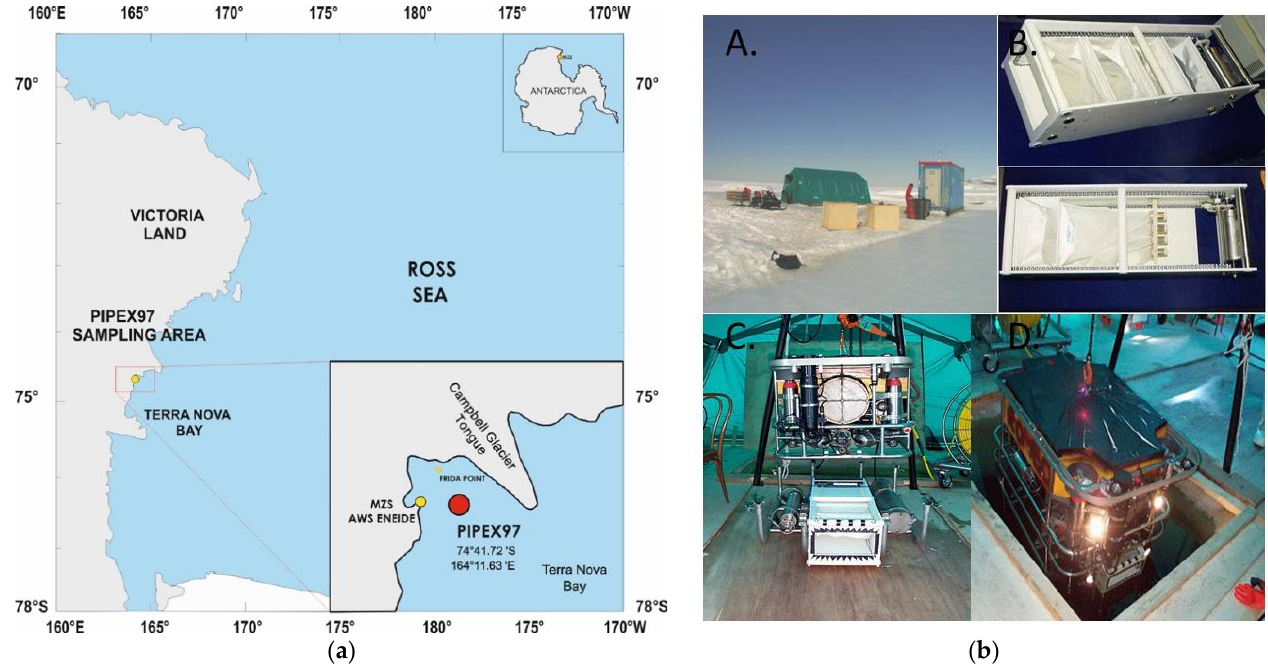
Figure 1. The field settings at the PIPEX 97 project sampling area, Terra Nova Bay, Antarctica, 1997. ( a ) The positions of the meteorological (ENEIDE) and the oceanographic (FRIDA) stations. ( b ) The biological station and the details inside the tent during field activities: (A) the sampling area on the pack-ice; (B) top view of the MicroNESS and position of the 4 sampling nets; (C) the attachment of MicroNESS to the ROMEO structure; (D) the deployment of the system through the hole in the ice.